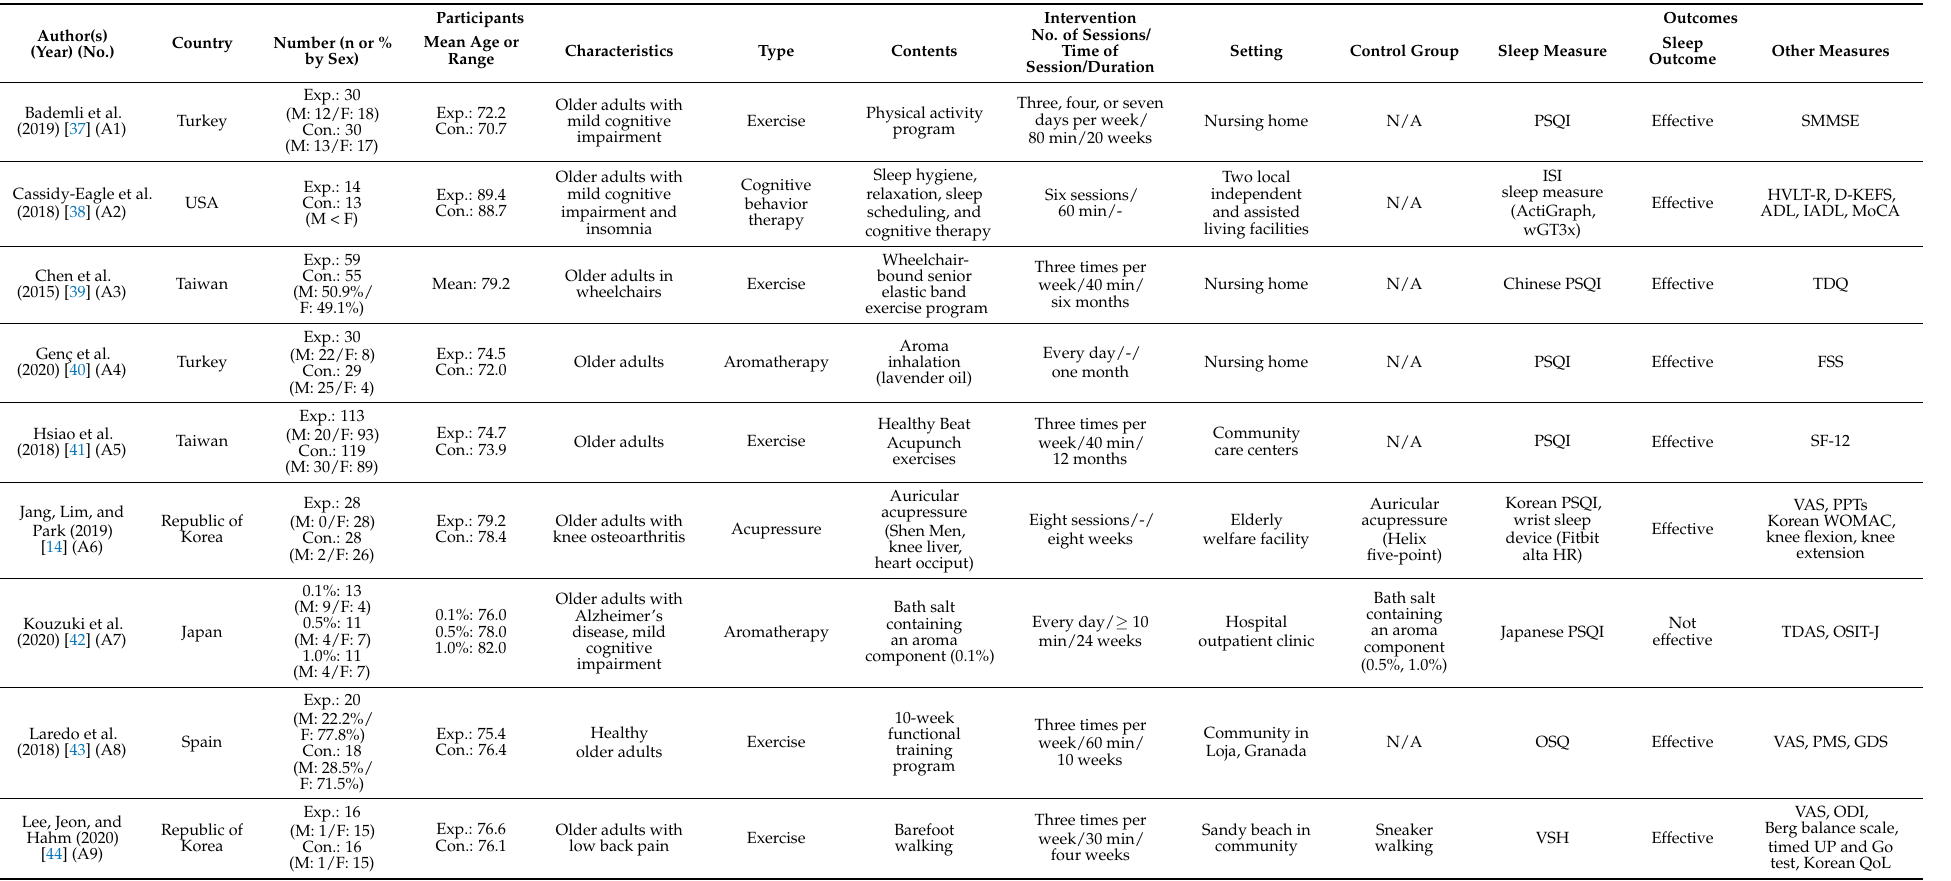
No. of Sessions/ Setting Control Group Sleep Measure Sleep Outcome Other Measures Time of Session/Duration